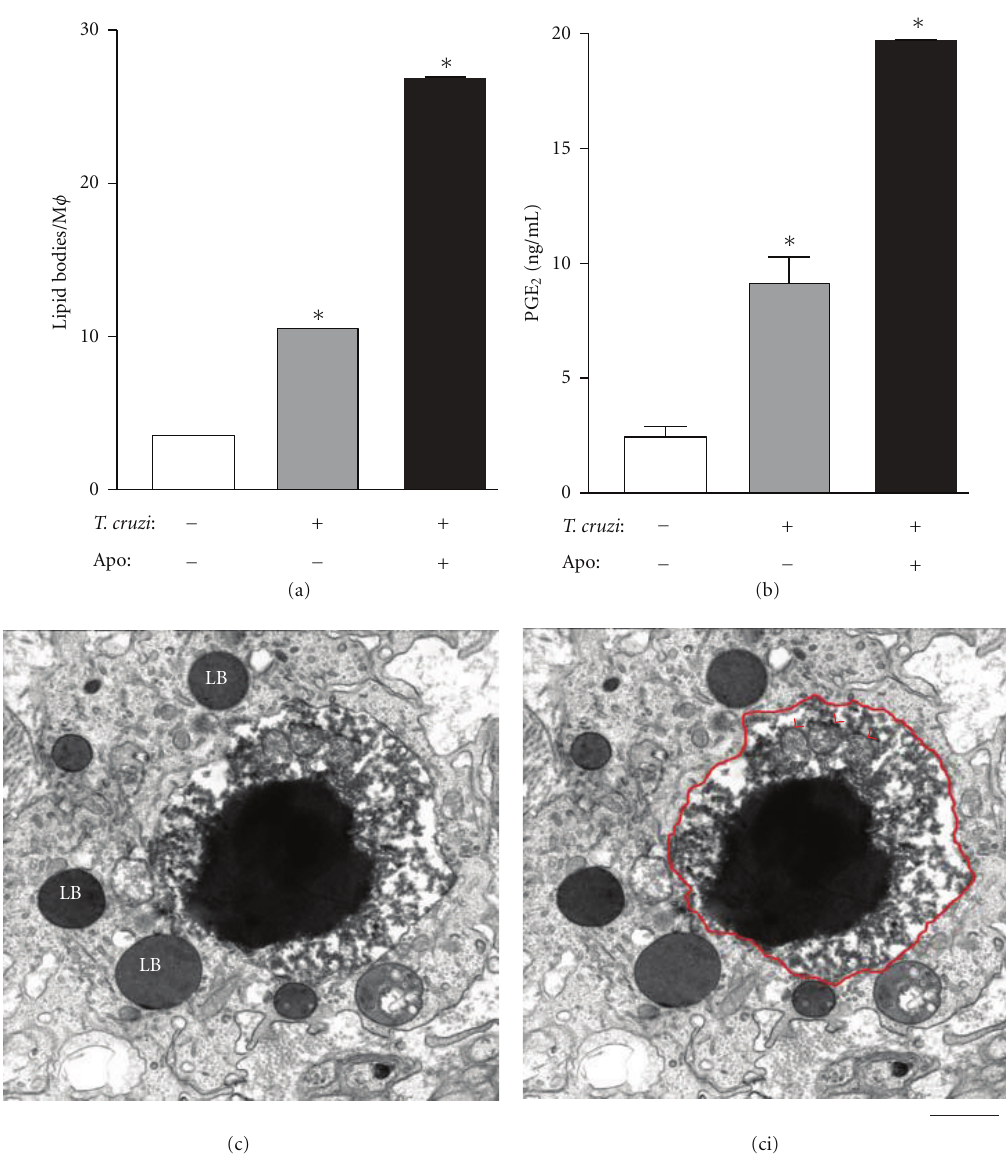
Figure 6: Uptake of apoptotic cells by macrophages induces lipid body formation and PGE 2 synthesis during Trypanosoma cruzi infection. LB formation (a) and prostaglandin E 2 (PGE 2 ) synthesis (b) by mice macrophages infected in vitro with T. cruzi alone or co-cultured with apoptotic cells for 24 hours. Each bar represents the mean ± standard error of the mean (SEM) from 50 consecutively counted macrophages from at least 4 independent pools of 3 animals each. Statistically significant ( P # 0.05) di ff erences between control and infected or stimulated groups are indicated by asterisks; M φ , macrophages. In (c), a large typical apoptotic body (outlined in red in (ci)) showing very condensed, electron-dense nuclear chromatin and degenerating mitochondria (red arrowheads) is seen within a heart macrophage of a rat with 12 days of infection. Note that the apoptotic body is surrounded by several lipid bodies with distinct electron densities. Rats were infected with the Y strain of T. cruzi and the myocardium processed for transmission electron microscopy at day 12 of the acute infection. Reprinted from [35] with permission. Scale bar, 1 μ